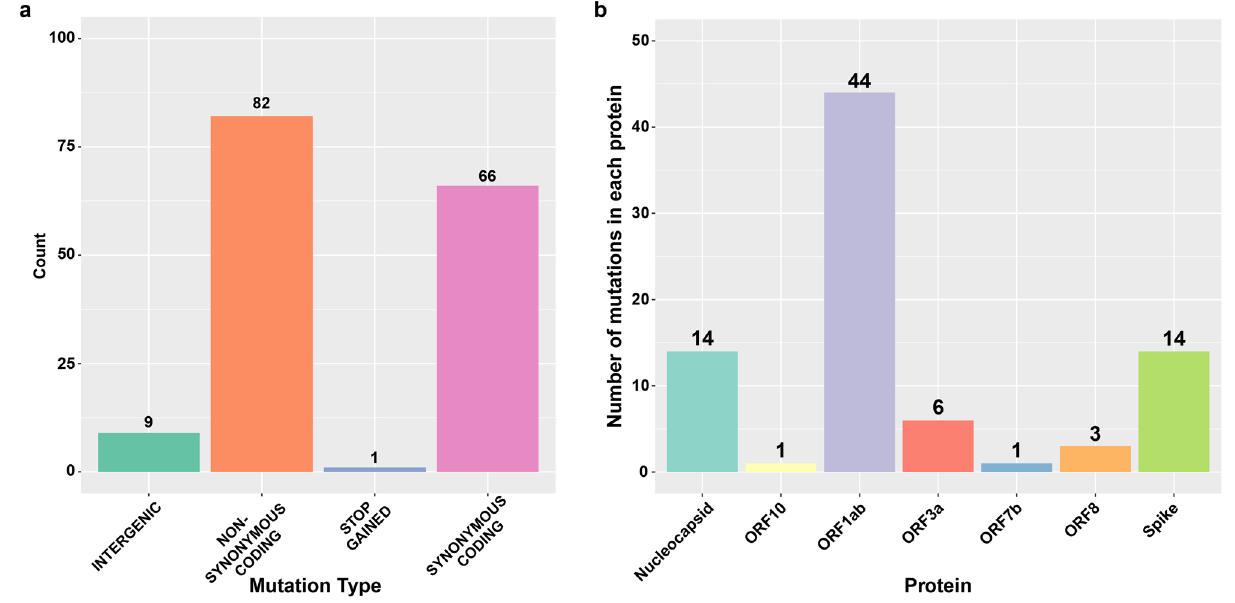
Figure 2. Bar charts showing mutation types and mutations affecting protein. ( a ) Shows different types of mutations detected in the samples. ( b ) Mutations affecting coding regions; nonsynonymous coding and stop codon gain, are divided according to affected protein.